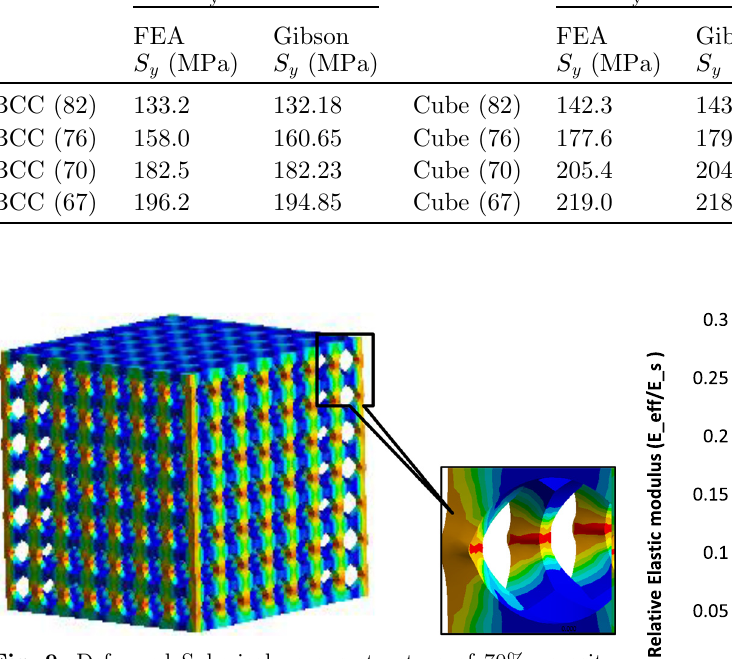
Table 3. FEA and Gibson-Ashby yield strengths of all porous structures with different porosities. Porous structures